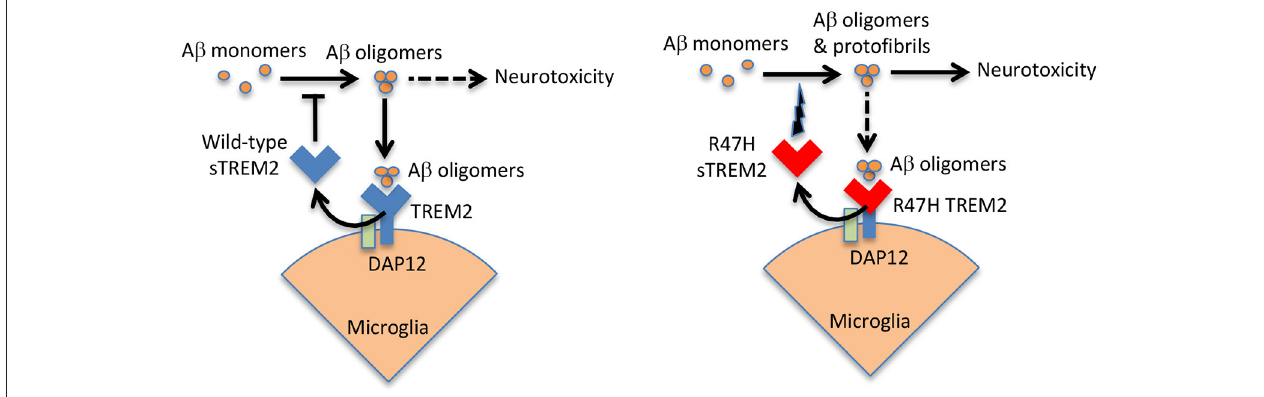
FIGURE 2 | Wild-type sTREM2 blocks A β pathology, but R47H TREM2 does the opposite. A β oligomers bind to TREM2 and induce shedding of sTREM2. Wild-type sTREM2 blocks A β oligomerization, fibrillization and neurotoxicity. R47H sTREM2 increases A β oligomerization, fibrillization and neurotoxicity. Thus, wild-type sTREM2 may protect against amyloid pathology, while R47H TREM2 exacerbates amyloid pathology. This might help explain why a single copy of the R47H TREM2 gene increases AD risk several